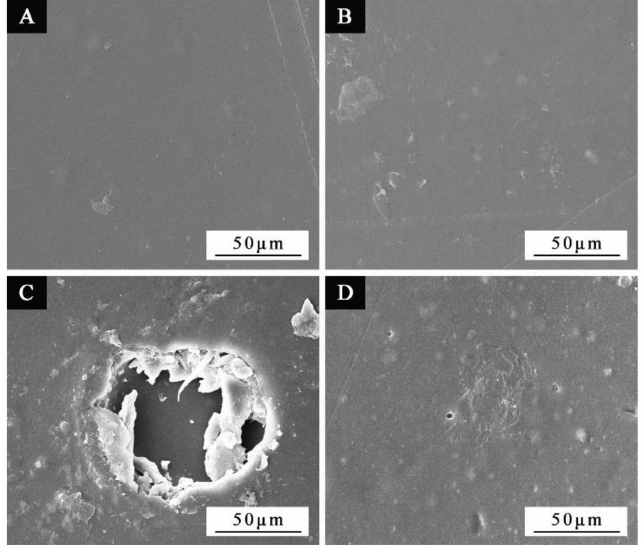
Figure 6. SEM images of coating films with and without microcapsules before and after 120 ◦ C aging: without microcapsules ( A ) before aging, ( C ) after aging; with microcapsules ( B ) before aging, ( D ) after aging.